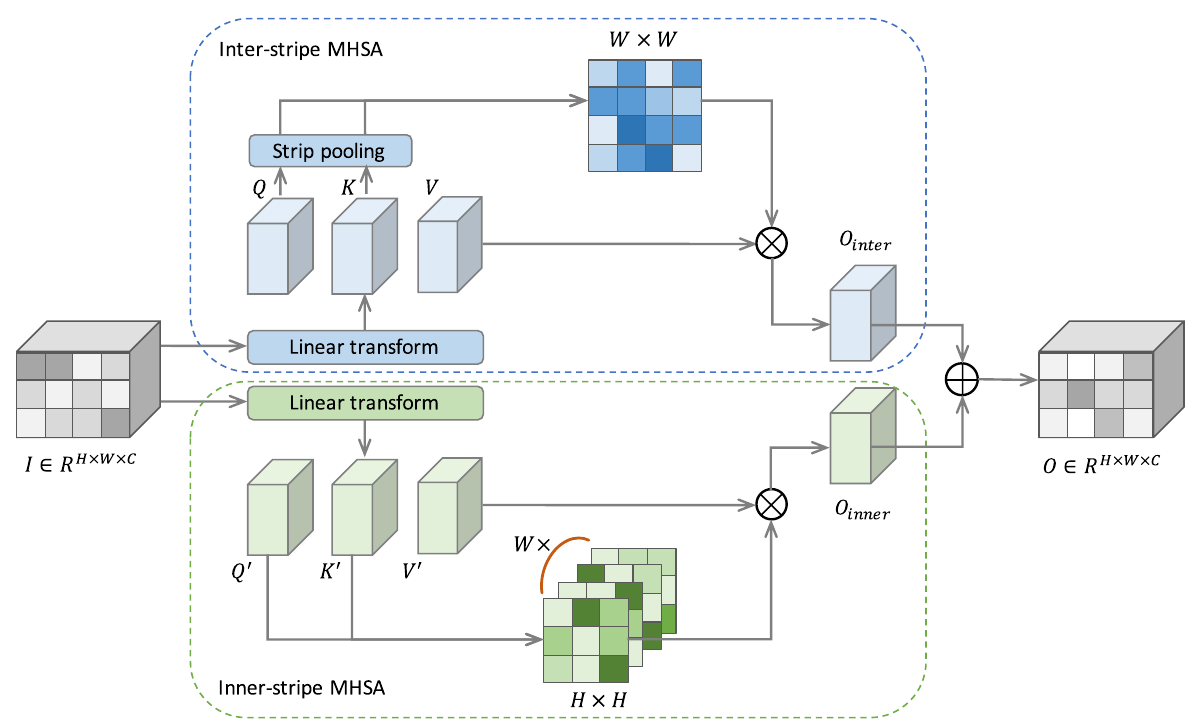
Fig. 3 The illustration of the vertical branch of the stripe-wise self-attention module ( SiSA V